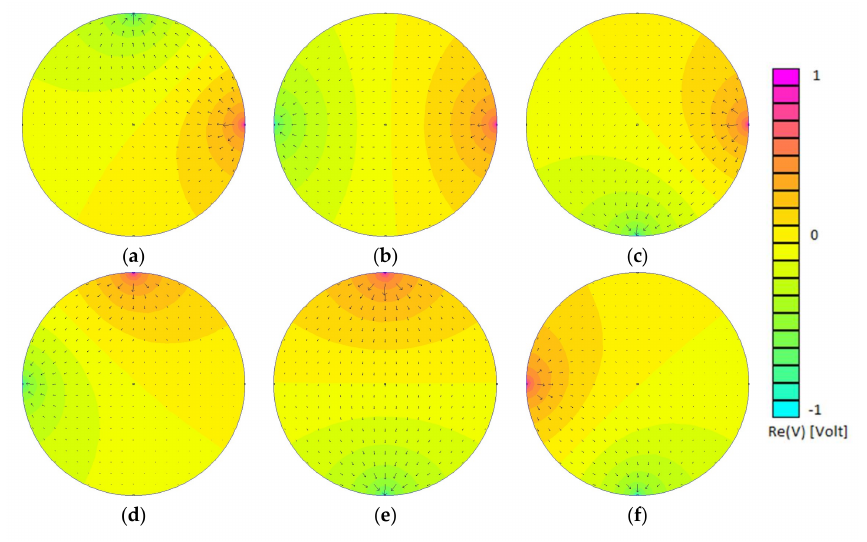
Figure 2. Simulations of the electrical potential and current fields for the 6 excitations performed based on the full scan strategy. Subfigures ( a – f ) correspond to 1st, 2nd, 3rd, 4th, 5th and 6th